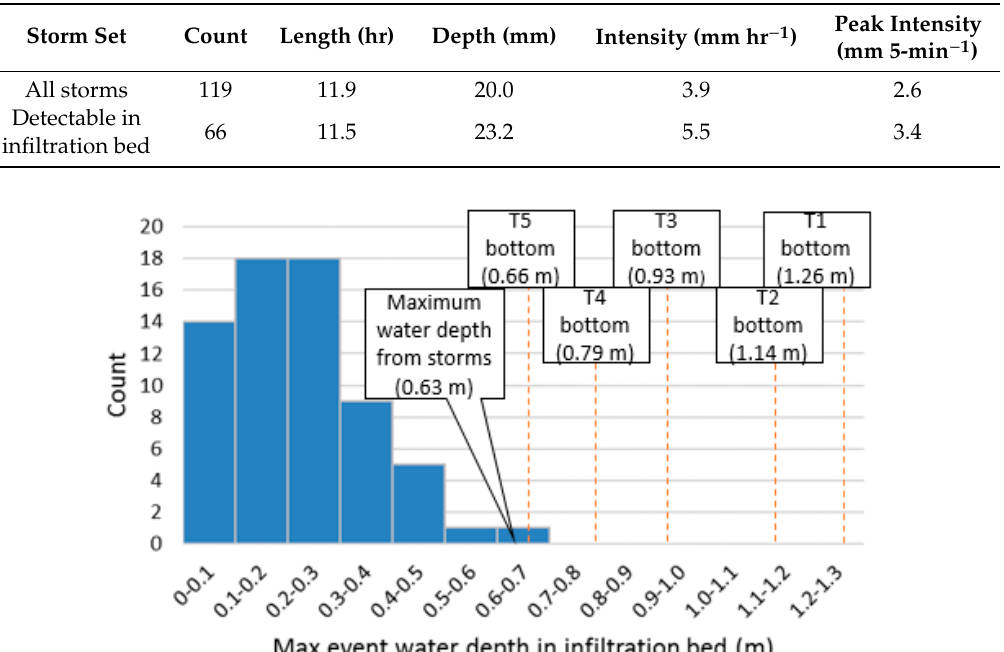
Table 2. Attributes of storms that occurred at the focal tree trench during the study period (March to April 2018). 2015 to April 2018).